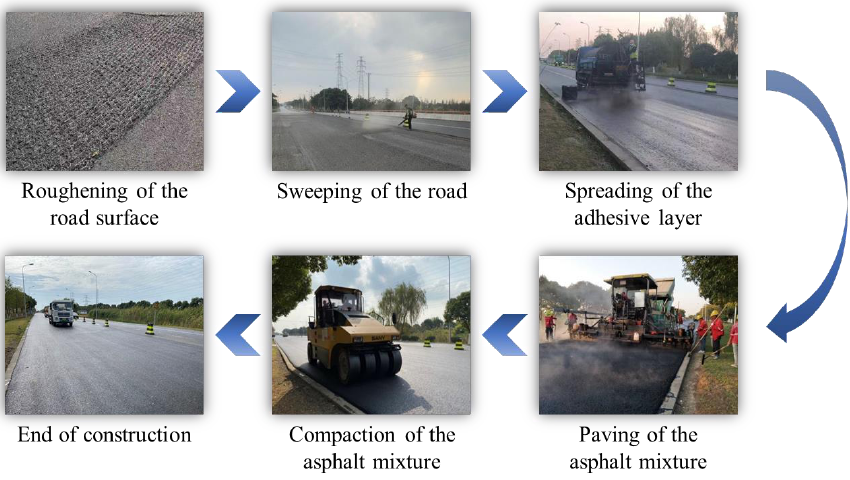
Figure 6. The field construction process of HWU asphalt overlay.